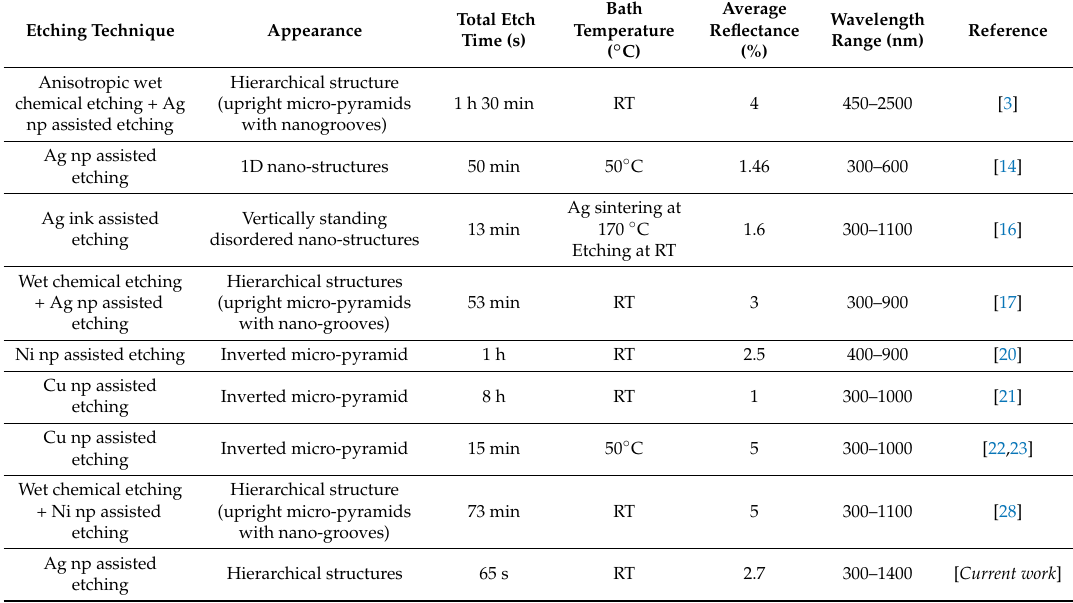
Table 1. Surface reflectance comparison on hierarchical structured and inverted micro-pyramidal structured